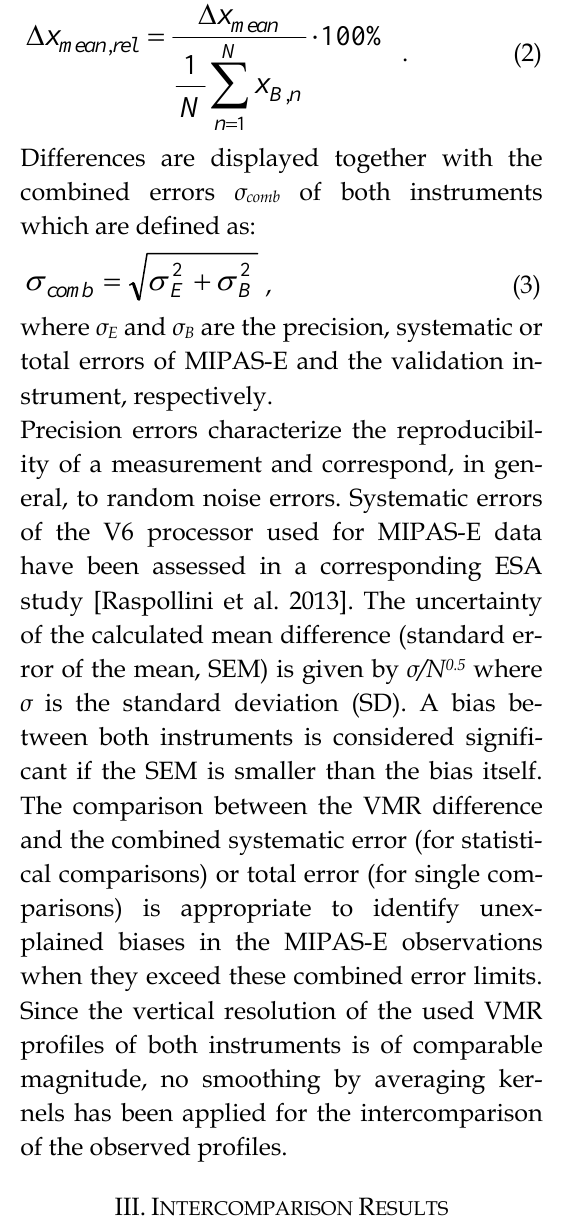
Table 1: Overview of MIPAS-B flights used for inter- comparison with MIPAS-E. Distances and times between coincident trace gas profile pairs observed by MIPAS-E and the validation instrument refer to an altitude of 20 km (Kiruna) and 30 km (Aire-sur-l’Adour and